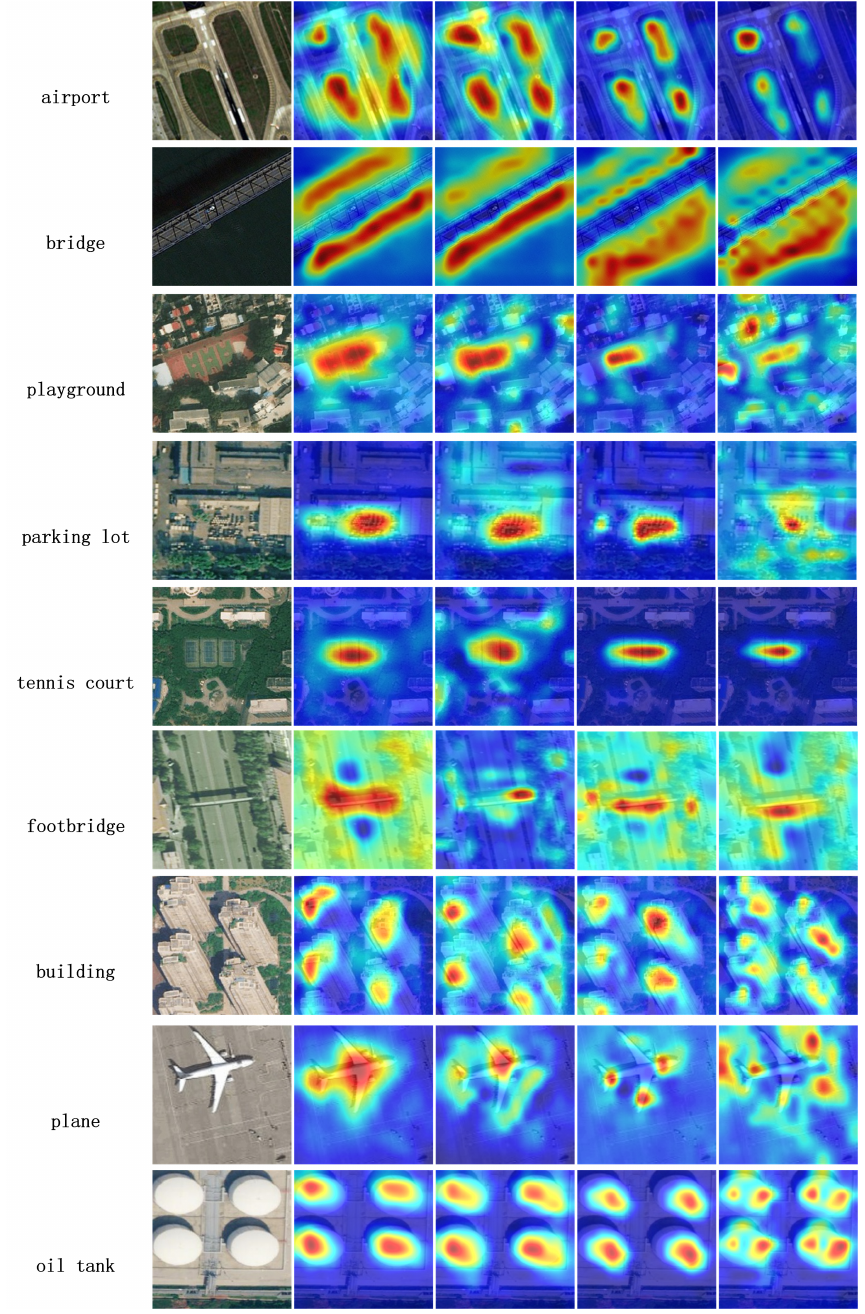
Figure 6. Feature Weighted Maps of the DCC models. The first column of each row is the original image. The second to the fourth columns are the FWMs extracted by the ADCC64, Alexnet, VDCC64 and VGG models,